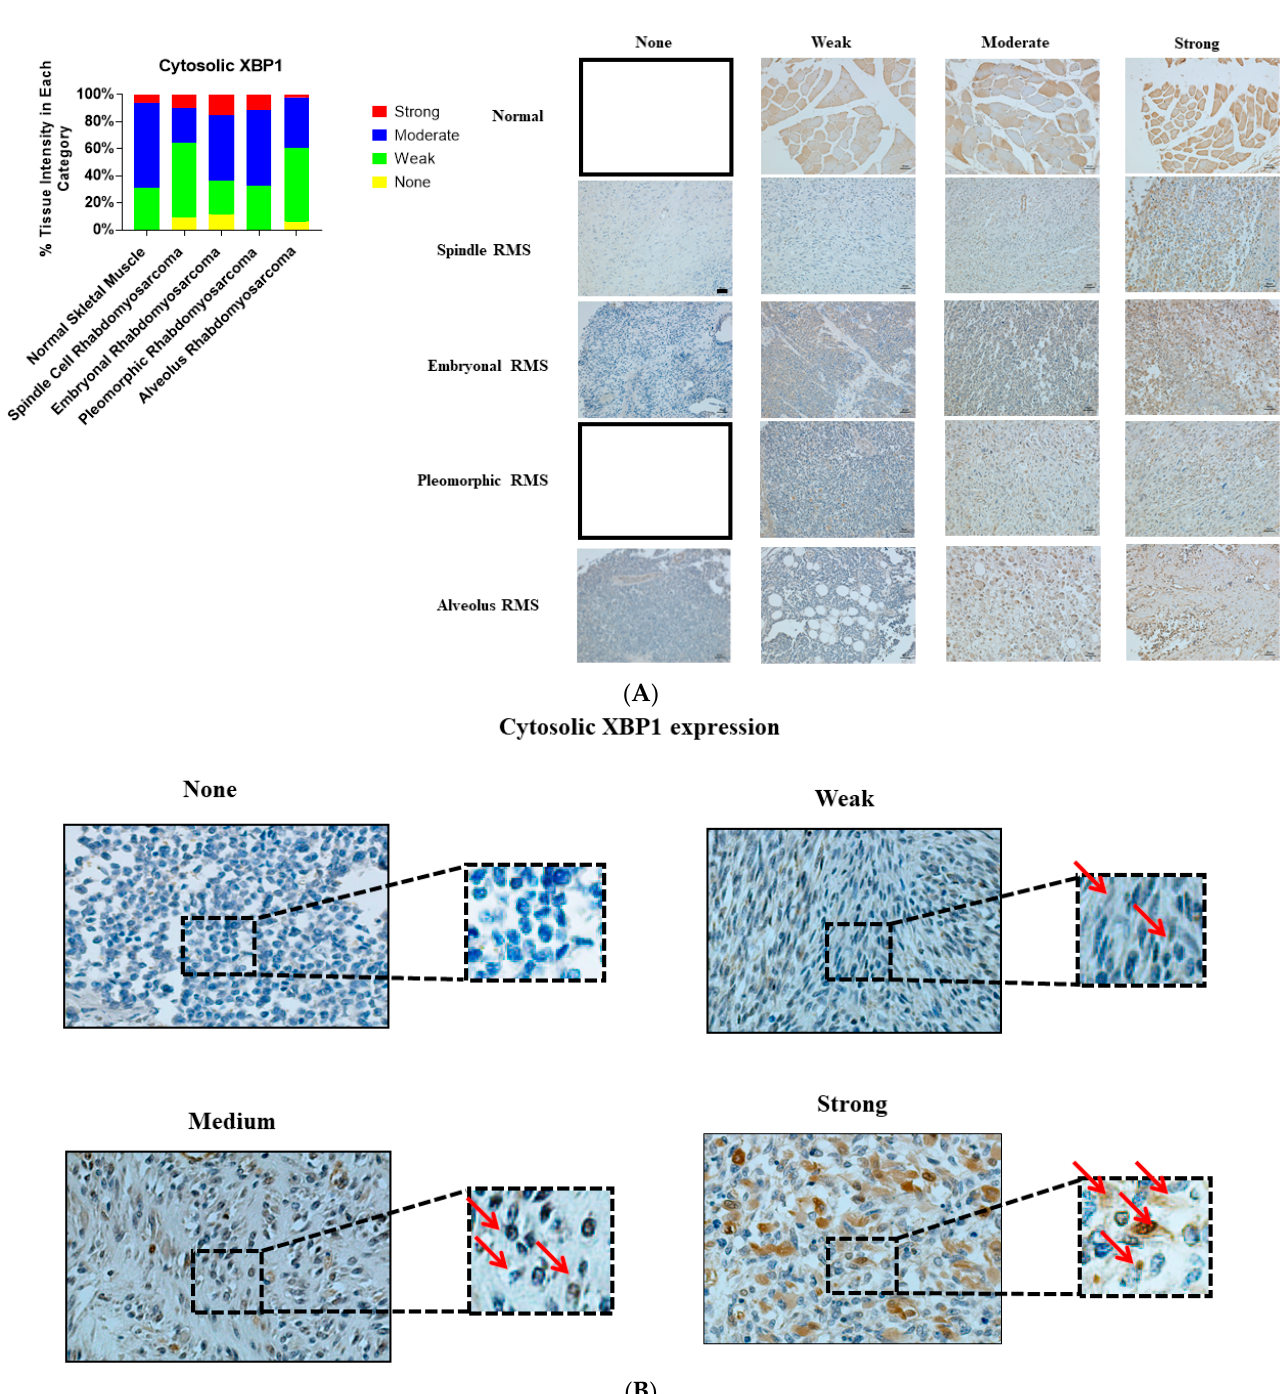
Figure 4. Immunohistochemical staining for cytosolic XBP1 in human skeletal muscle and RMS tissue. ( A , B ). We detected cytosolic XBP1 expression (red arrows) in a human RMS TMA. Details on the TMA were outlined in the Materials and Methods section. Three independent pathologists blindly evaluated the immunohistochemical cytosolic XBP1 expression (None = no staining; W: Weak staining; M: Moderate staining; S: Strong staining); the empty slots indicate that no samples matched the specifics of that group. Our results show that cytosolic XBP1 is associated with ARMS and SRMS (Table 4). The scale bar refers to 50 µM.